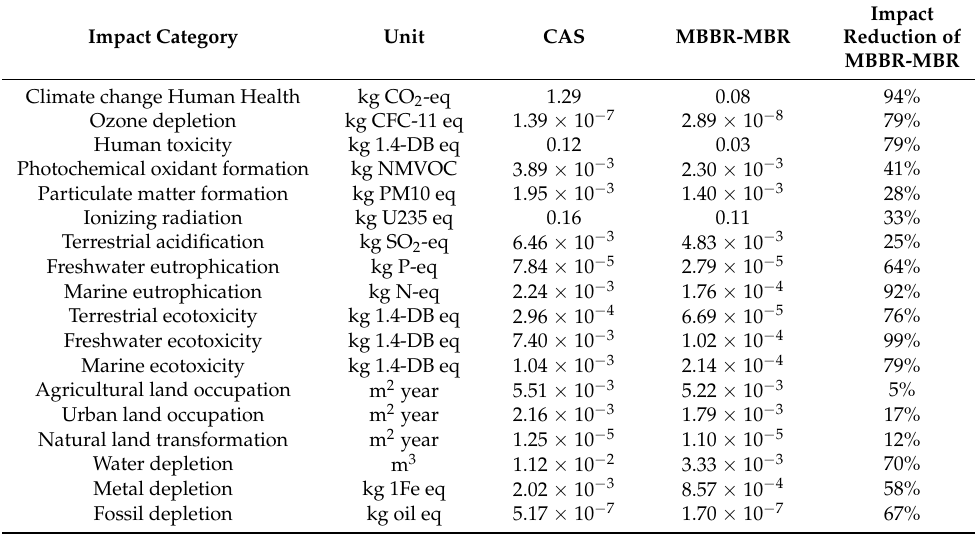
Table 11. Comparison of CAS and MBBR-MBR: midpoint